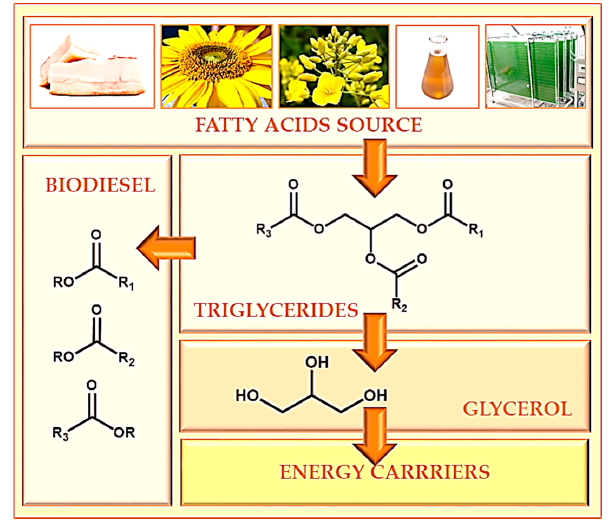
Figure 1. Production of energy carriers from biodiesel and glycerol.